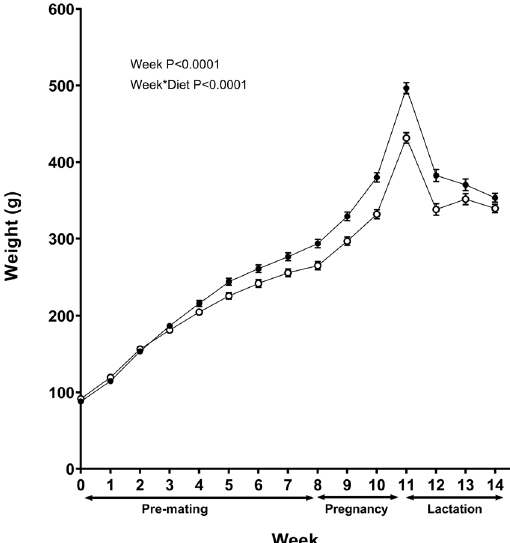
Figure 1. Maternal weight during pre-mating, pregnancy and lactation. Values are for mean and SEM. Animals were fed either a control diet (C, open circles, n 13) or a cafeteria diet (O, closed circles, n 12). Pre-mating (weeks 0–8), pregnancy (weeks 8–11), lactation (weeks 11–14). Weight gain at week 12 was calculated from the initial lactation weight of female dams after birth. Some animals were excluded from the analysis due to assessment of extreme outliers or data missing. Statistical analysis was by repeated measures